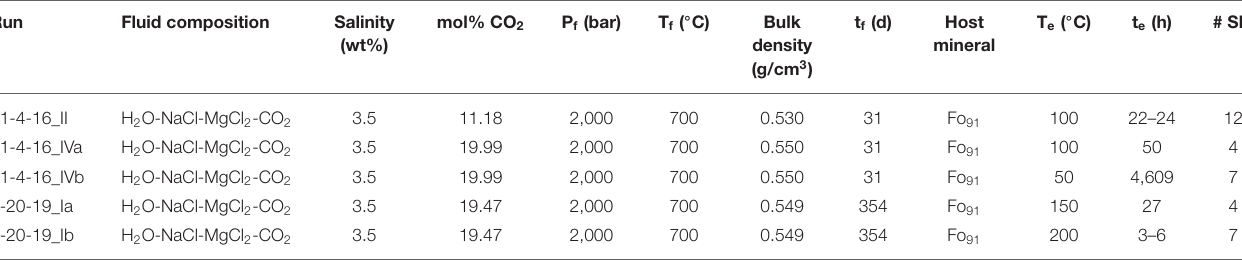
TABLE 1 | Summary of conditions of formation of the synthetic fluid inclusions and olivine carbonation experiments. Run Fluid composition Salinity